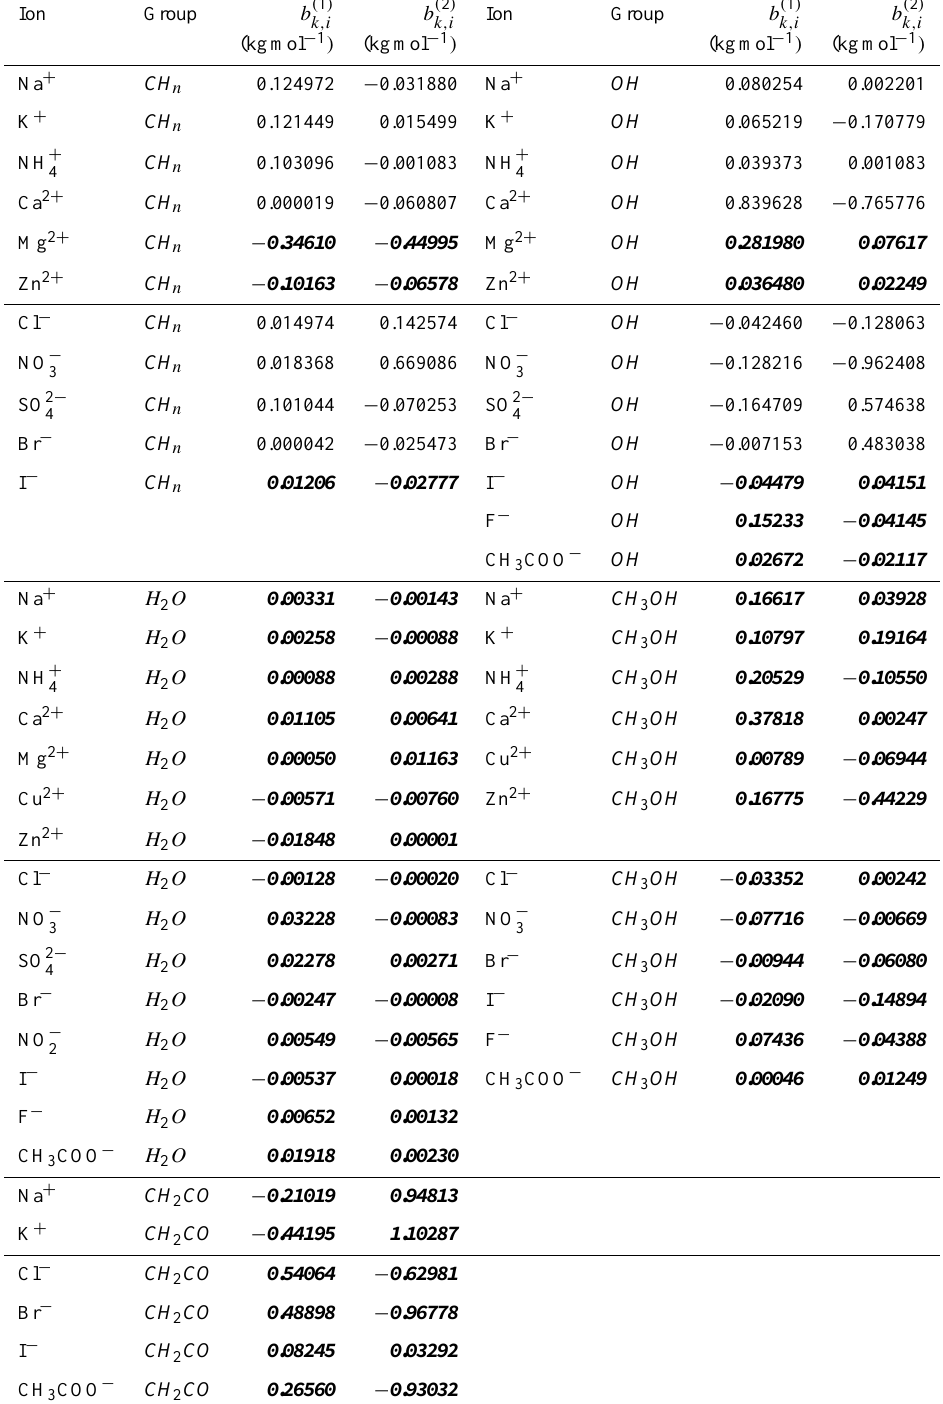
and b ( 2 ) between solvents and ions (AIOMFAC – regular/ mod. LIFAC – bold italic k,i k,i